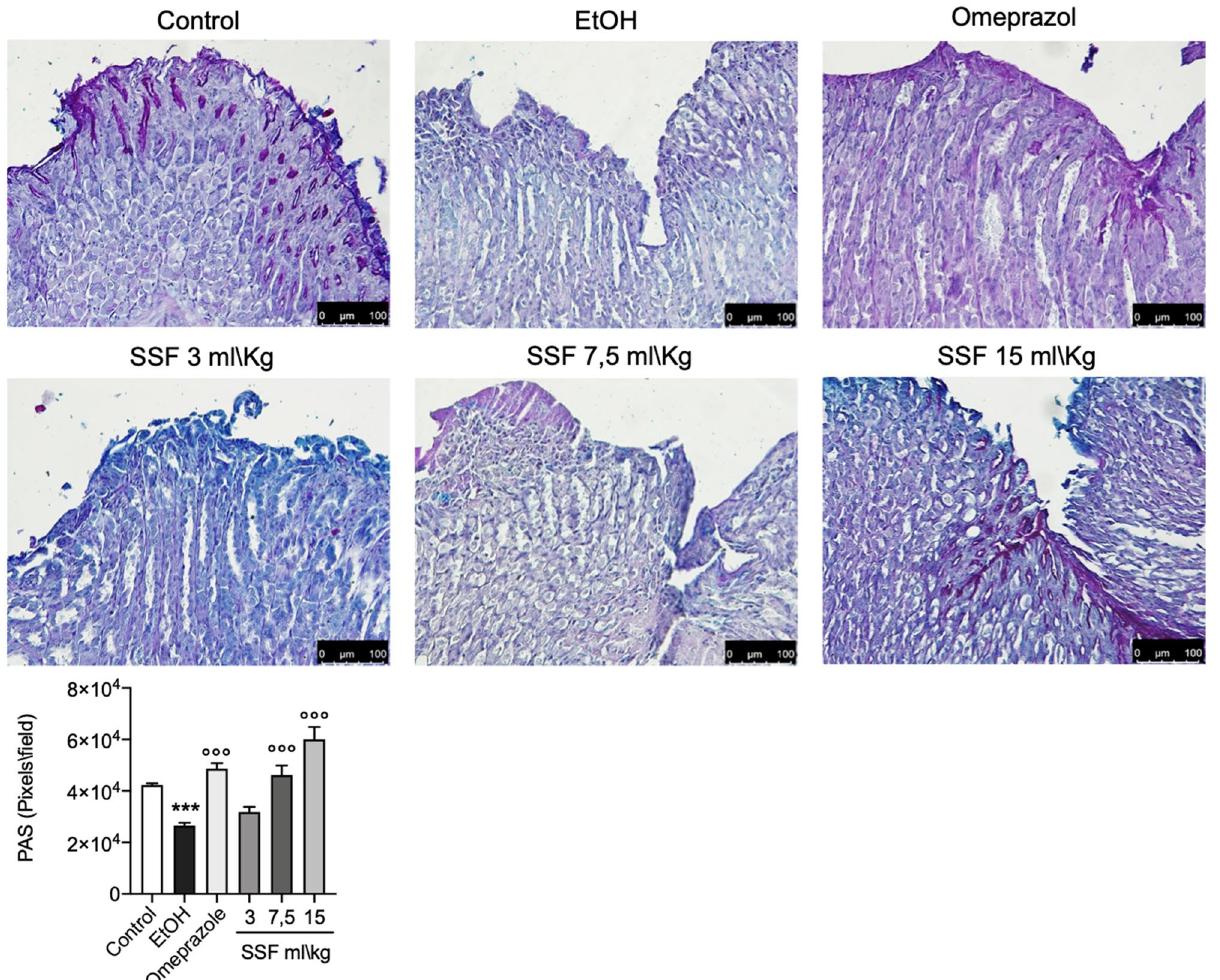
Figure 4. PAS staining from control group showed the normal contents of mucosa glycoprotein(magenta color); EtOH group showed a significantly reduction in PAS staining, significantly inhibited by treatment wit omeprazole 20 mg/Kg; SSF treatment showed a dose dependent protective effect as showed by the increase of PAS staining. Image J software (1.49v, https ://image j.nih.gov/ij/, 1997–2018. Schneider, C.A., Rasband, W.S., Eliceiri, K.W.) was used for the quantification of glycoprotein as the positively stained area (pixel/field). Data are presented as means ± SEM of 10 mice for each group.***p < 0.001 versus control; ◦◦◦ p < 0.001 versus